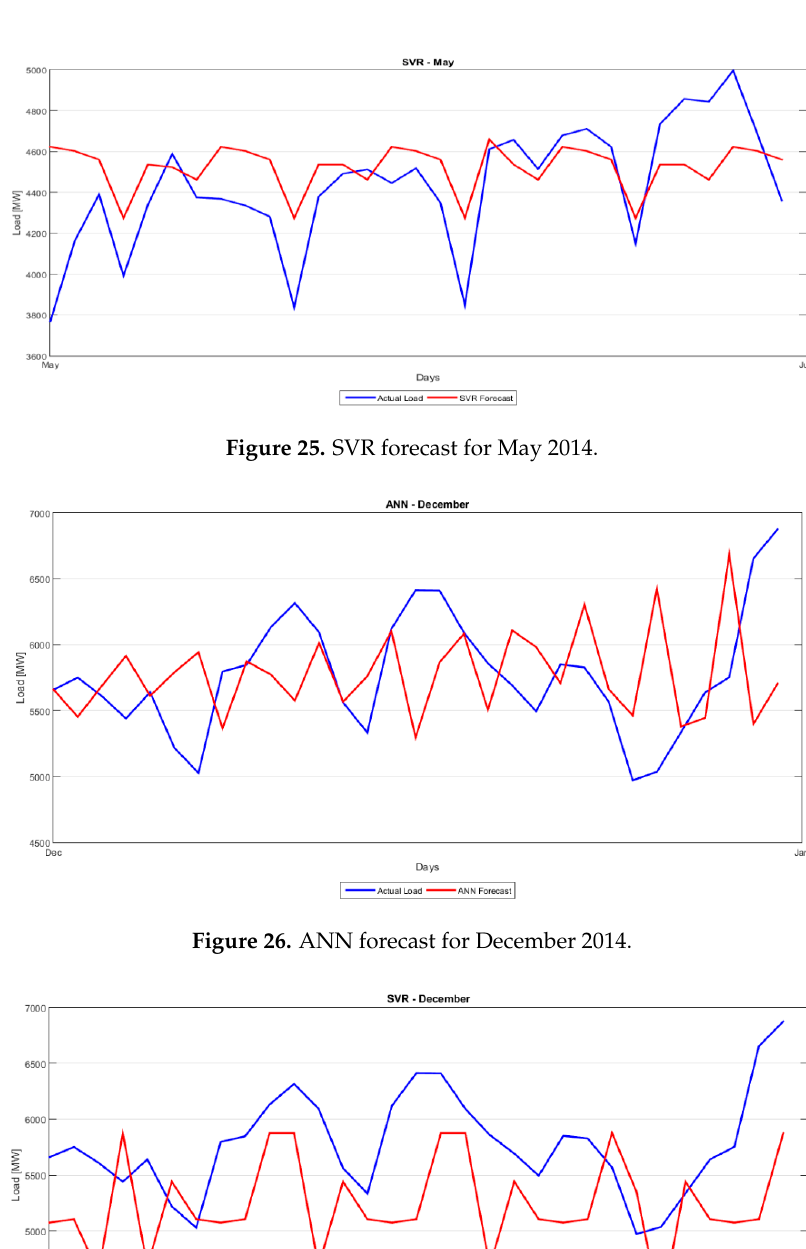
Figure 24. ANN forecast for May 2014.